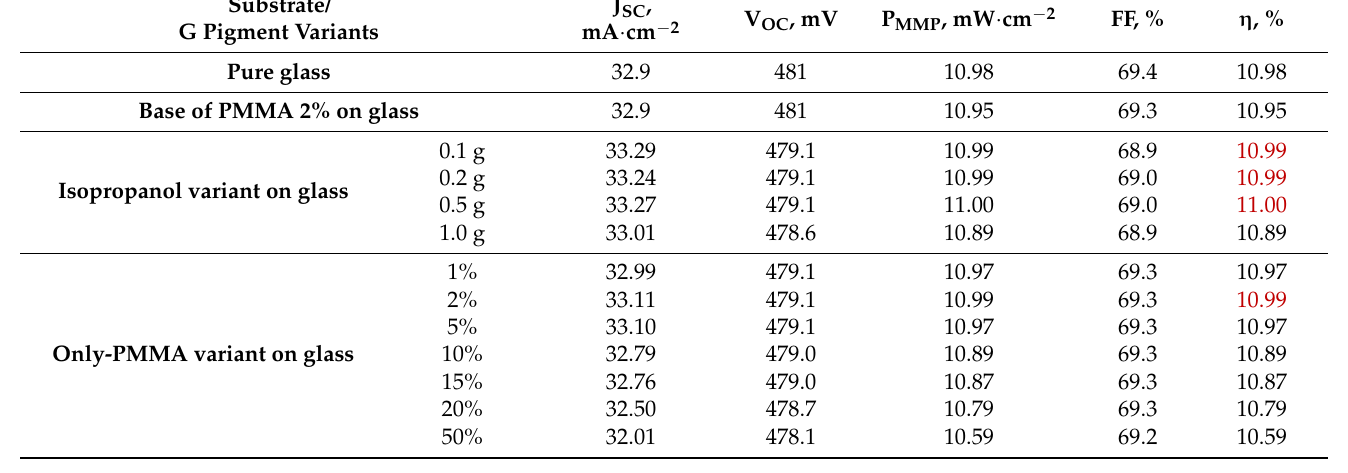
Table 4. The characteristic value of the model of photovoltaic panel without and with layers based on G by spray-coating deposition method in two variants.